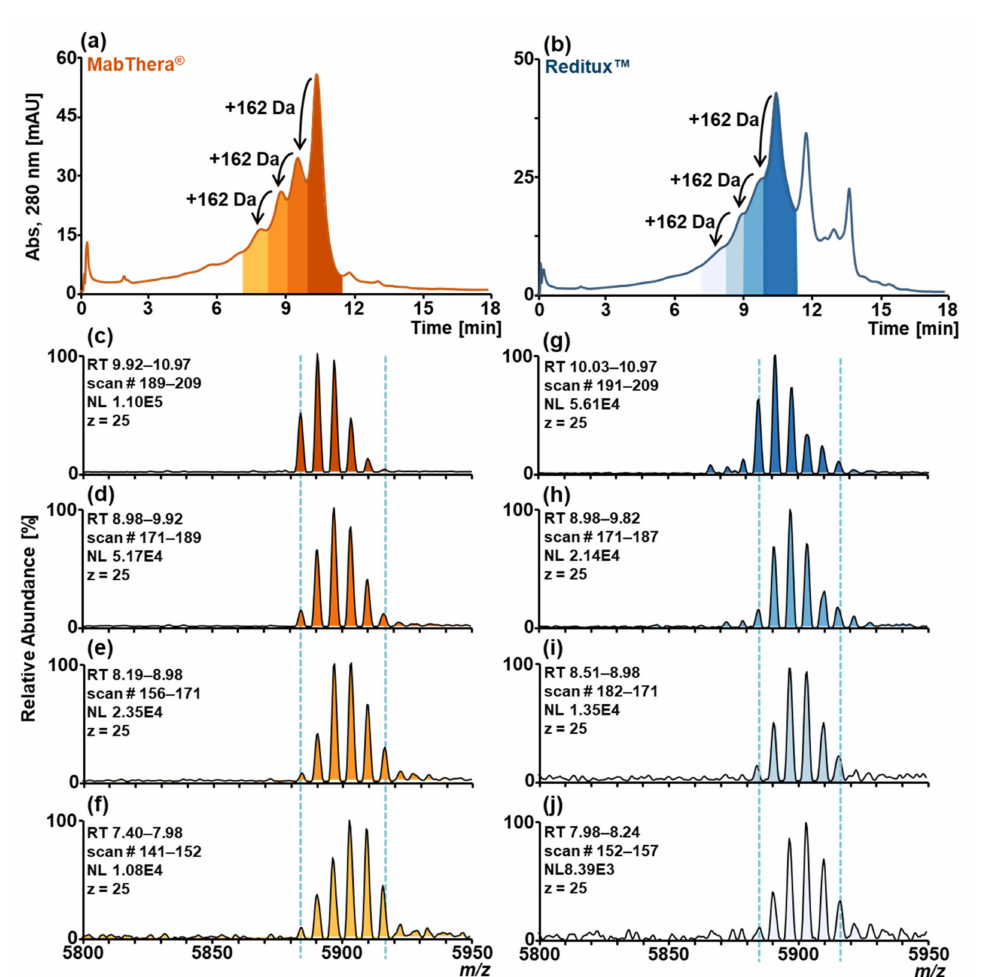
Figure 3. SCX-HPLC-MS chromatograms of forced glycated ( a ) MabThera ® (orange) and ( b ) Reditux™ (blue). Additional chromatographic peaks due to glycated variants are indicated by arrows (+162 Da). Magnification of charge 25+ of mass spectrum associated with ( c ) peak at RT 9.83–10.97 min of MabThera ® , ( d ) peak at RT 8.98–9.92 min of MabThera ® , ( e ) peak at RT 8.19–8.98 min of MabThera ® , ( f ) peak at RT 7.40–7-98 min of MabThera ® , ( g ) peak at RT 10.03–10.97 min of Reditux™, ( h ) peak at RT 8.98–9.82 min of Reditux™, ( i ) peak at RT 8.51–8.98 min of Reditux™, ( j ) peak at RT 7.98–8.24 min of Reditux™. A shift of 162 Da in the glycosylation pattern due to the glycation bias can be observed going to the more acidic variants (spectra c–f and